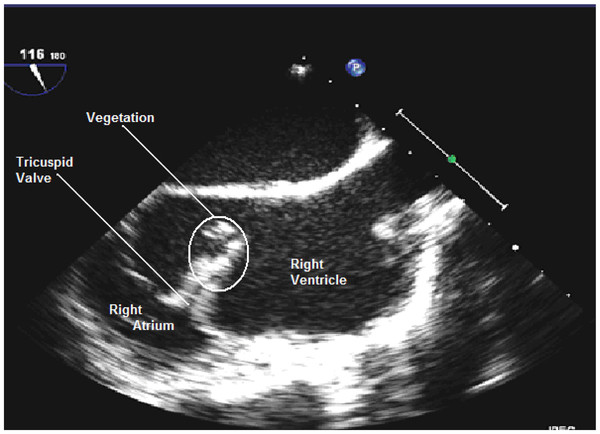
Transesophageal echocardiogram image of tricuspid vegetation. After initial imaging of the vegetation by a transthoracic echocardiogram, a transesophageal echocardiogram was performed to rule out an associated root abscess and in anticipation of a preoperative work-up.